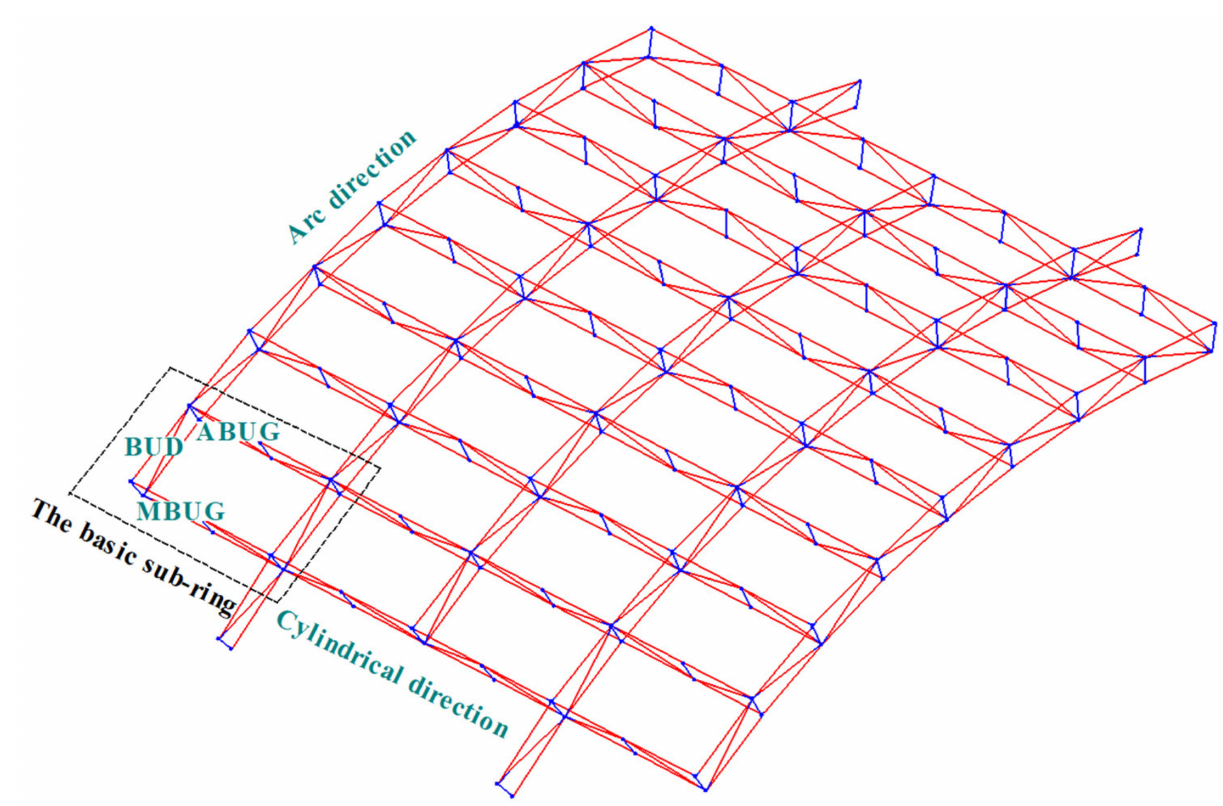
Figure 15. The deployable